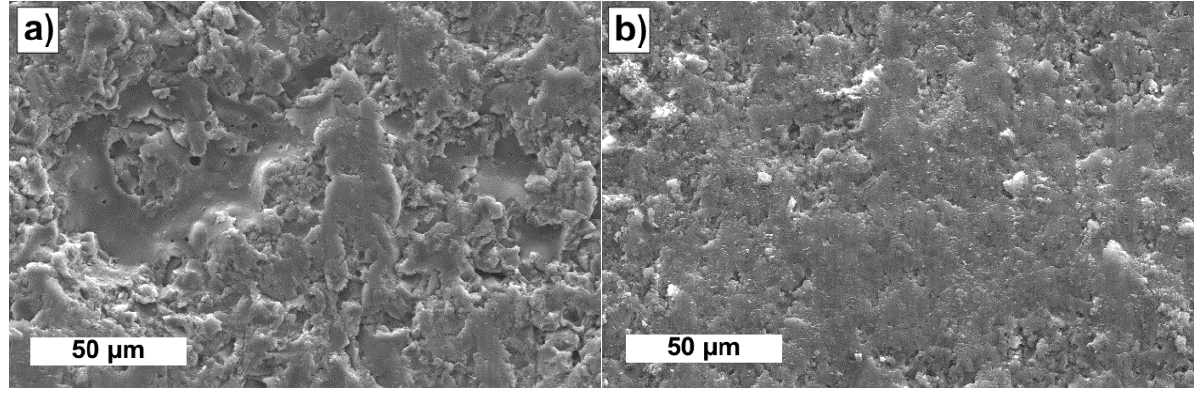
Figure 12. Worn surfaces of ( a ) APS_AT1 and ( b ) HVOF_A coatings after 60-minute abrasion wear